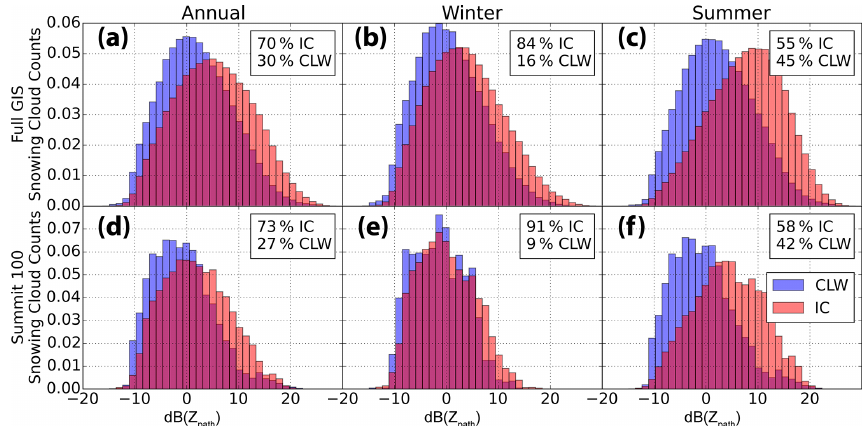
Figure 12. As in Fig. 11 but with dB (Z path )